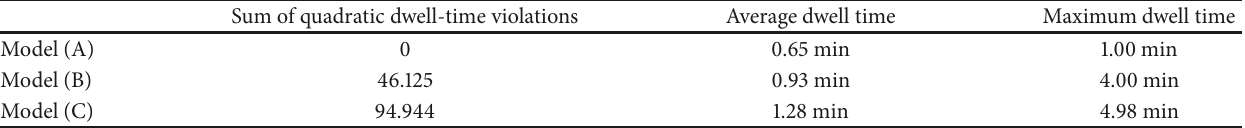
Table 3: The dwell time after